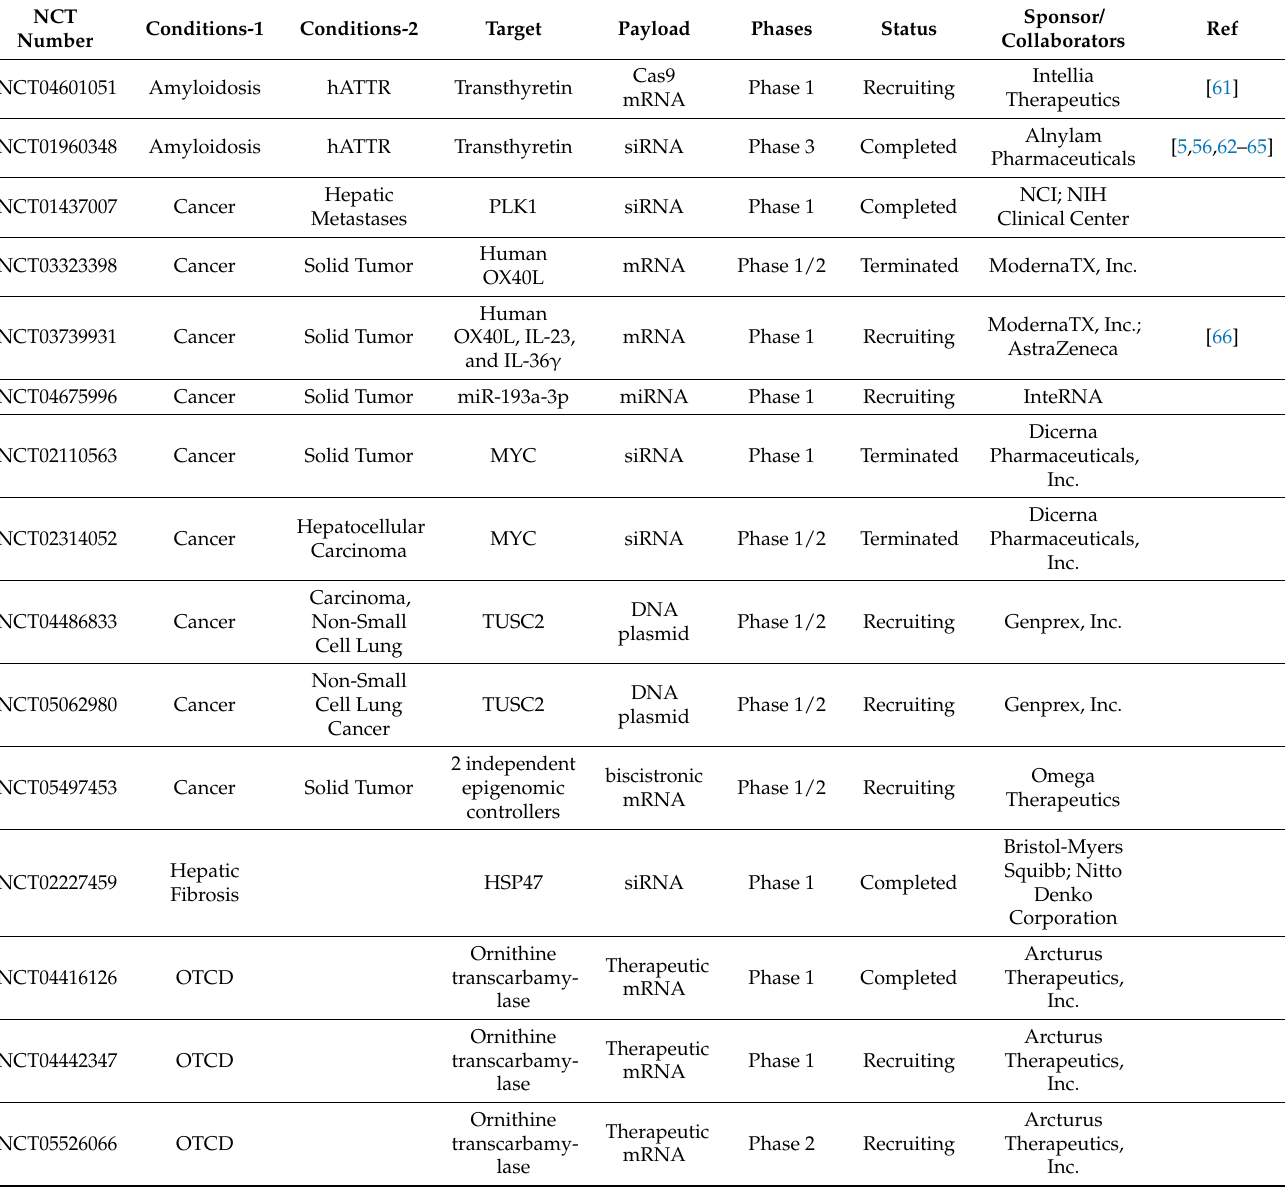
Table 5. Clinical trials of LNP-mediated gene